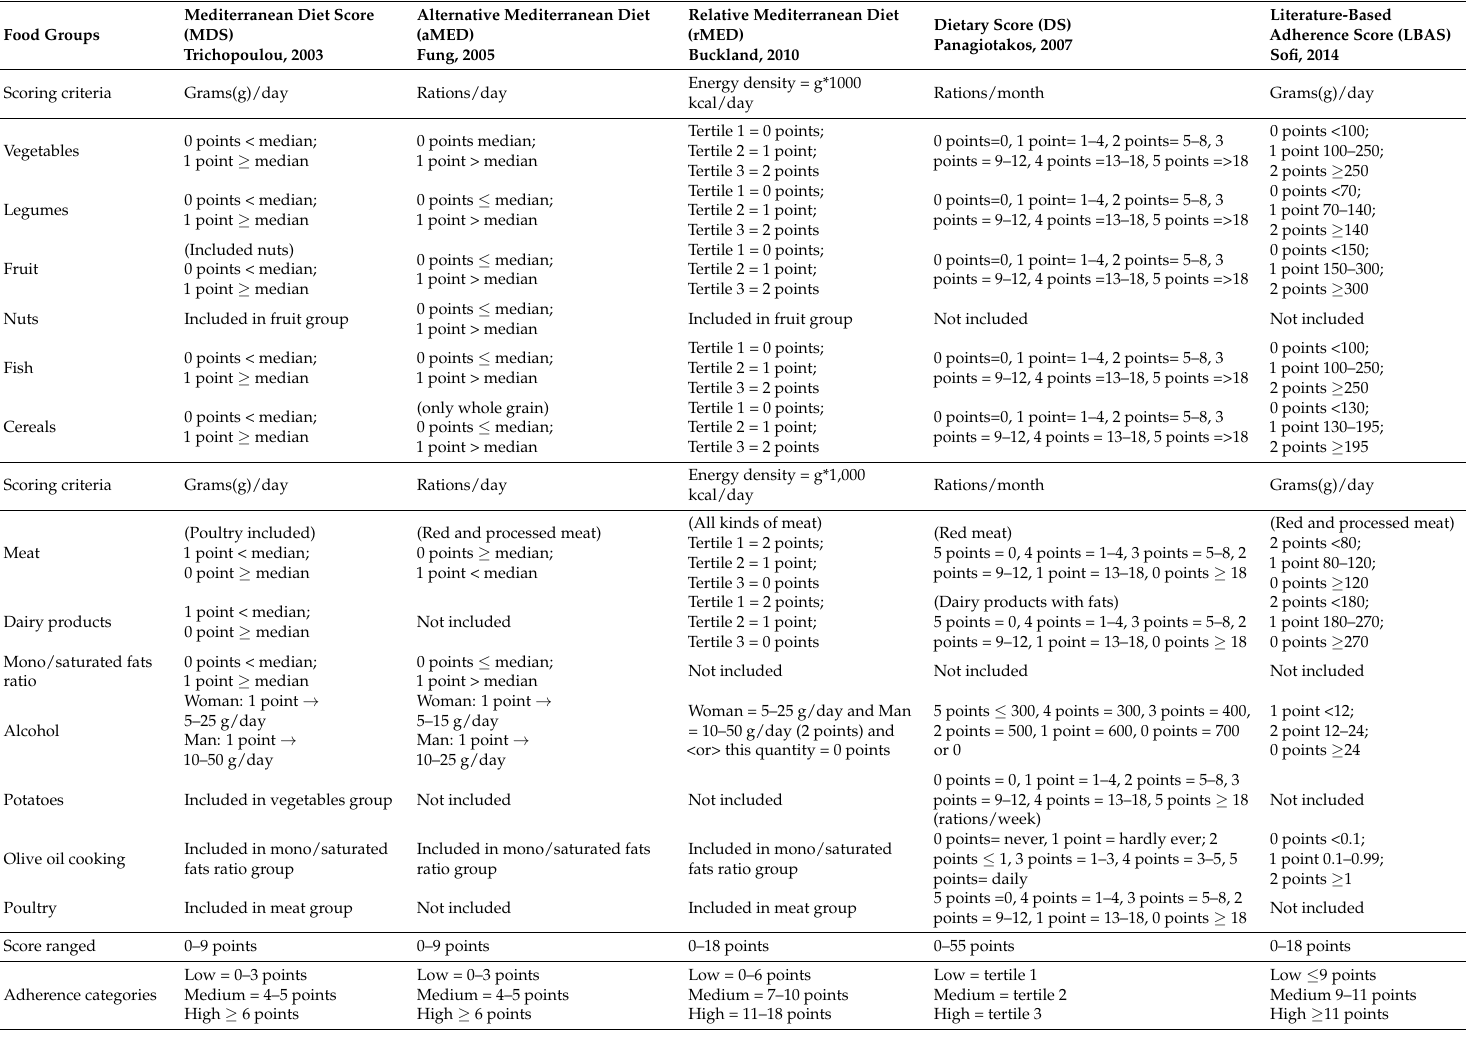
Table 1. Characteristics of Mediterranean diet pattern adherence